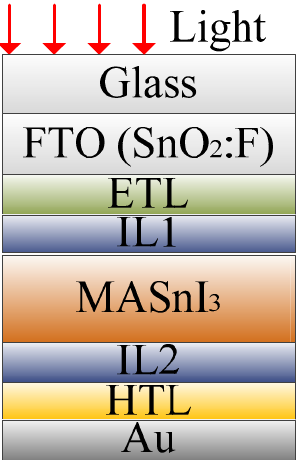
Figure 1. Configuration of the lead-free PSC.